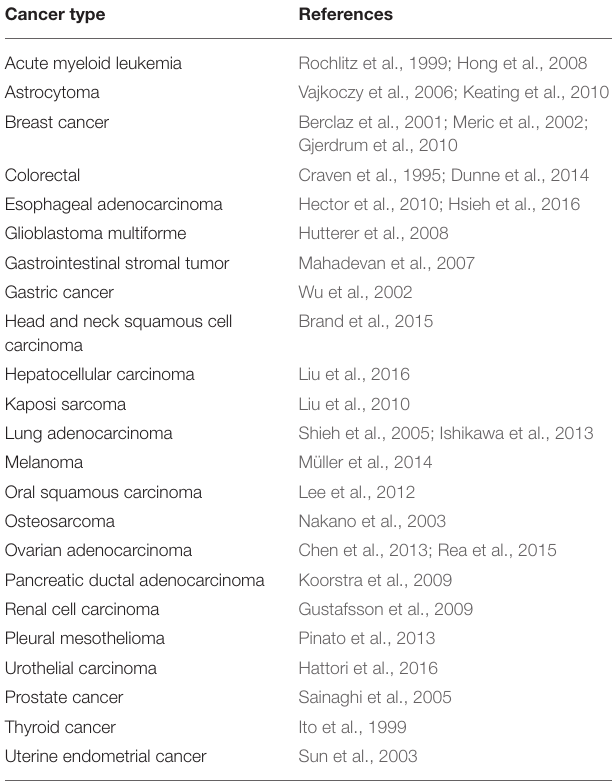
TABLE 12 | Expression of the Axl kinase in the different types of cancer